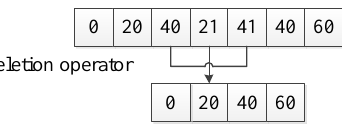
Figure 5. The deletion operator.